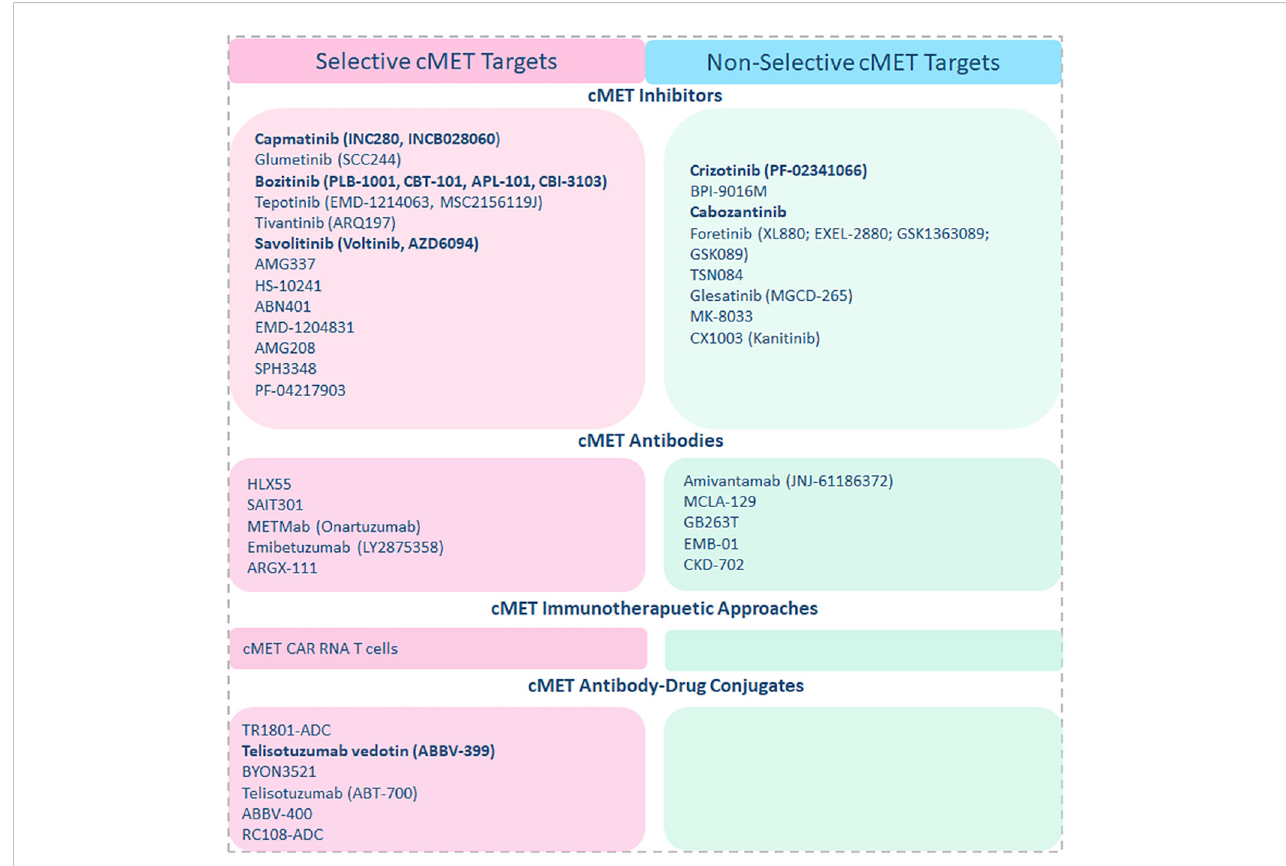
FIGURE 1 cMET-targeting approaches and agents in clinical trials are listed accordingly, and cMET-targeting agents currently being investigated in combination with ICI regimes are highlighted in the fi